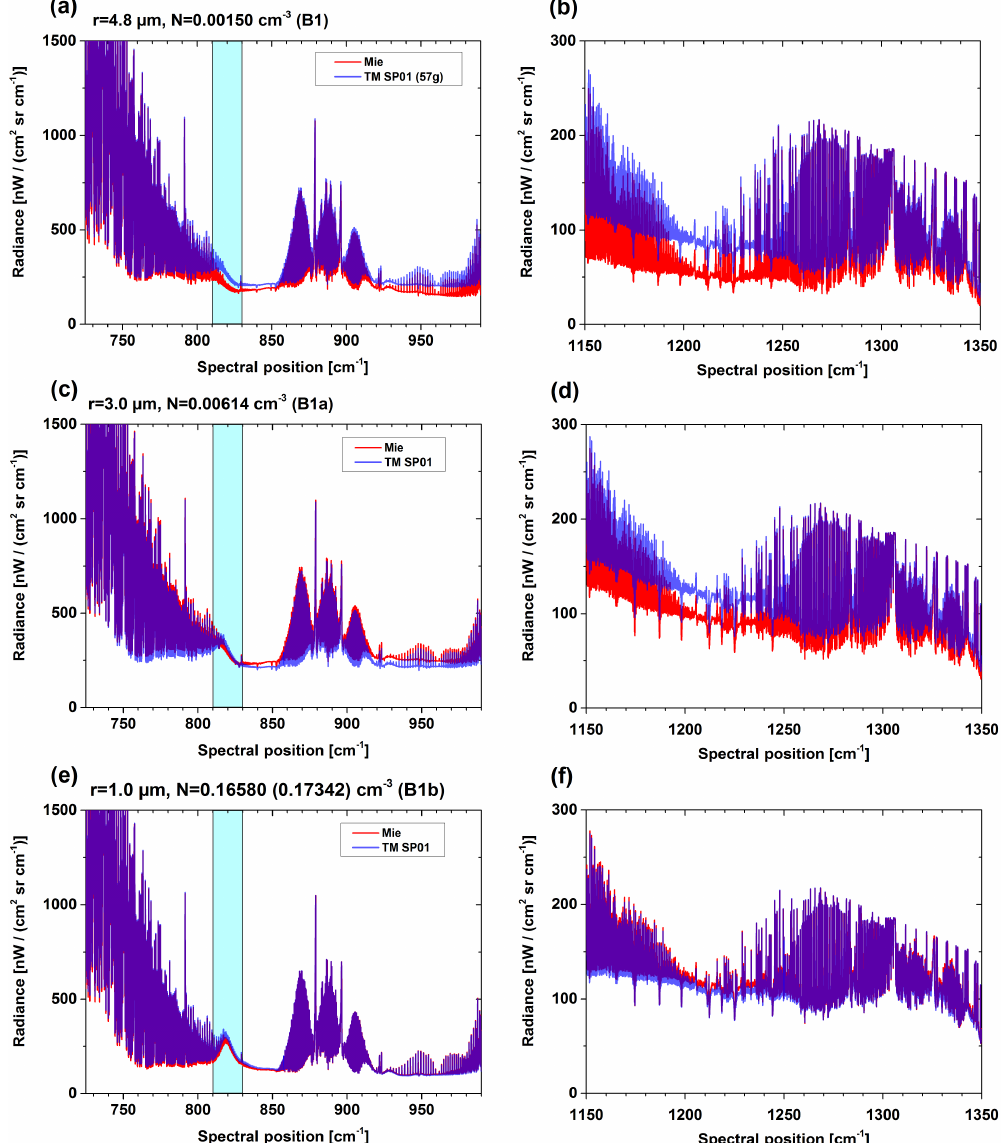
Figure B2. Sensitivity simulations investigating the effect of decreasing mode radii on the simulated spectral signatures of β -NAT particles for a T-Matrix scenario with AR = 0.1 (blue) and a corresponding Mie scenario (AR = 1.0, red). (a, b) Large particle mode, size distribu- tion B1. (c, d) Intermediate particle mode, size distribution B1a. (e, f) Small particle mode, size distribution B1b. Numbers above panels (a) , (c) , and (e) indicate corresponding mode radii and particle number densities (see Fig. B1). “TM” corresponds to T-matrix simulation and “SP” to spheroid (numbers indicate